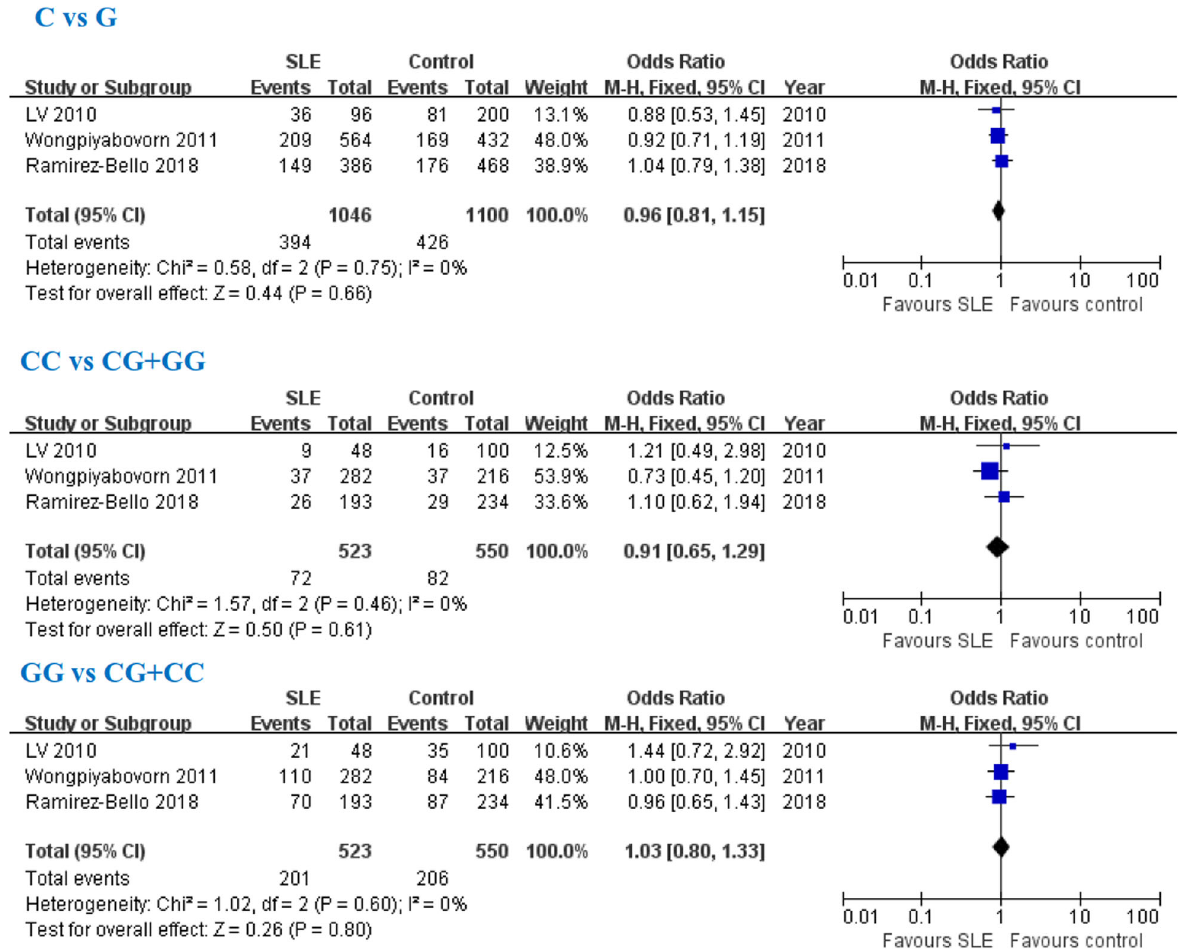
Fig. 4 Association between vascular endothelial growth factor -634G/C gene polymorphism (rs2010963) with SLE susceptibility. SLE: systemic lupus erythematosus; M-H: Mantel-Haenszel; Total: the total number of SLE group or control group; CI: confidence intervals; I 2 : test the heterogeneity among recruited studies; df: degrees of